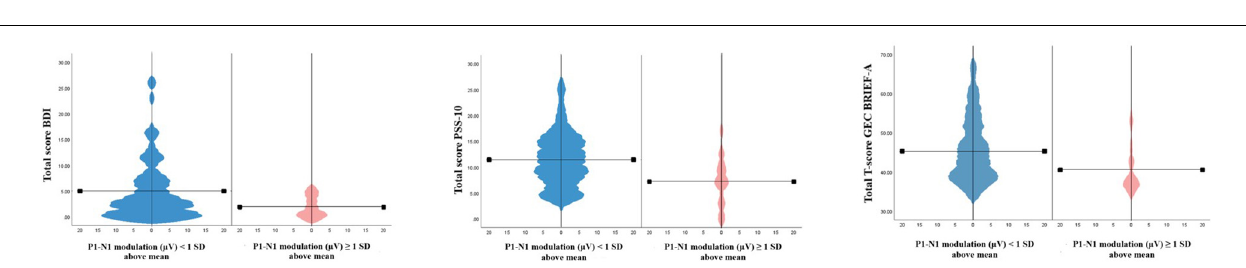
FIGURE 6 | Violin plots showing differences between participants with higher ( > 1 SD above mean, n = 16) and ( ≤ 1 SD above mean, n = 94), respectively. P1-N1 modulation ( µ V) on depressive symptoms, perceived stress and executive